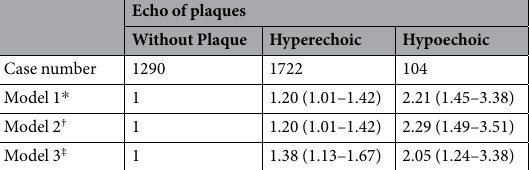
Table 4. Odds ratios of cognitive impairment by echo character of plaques. * Adjusted for age, sex. † Adjusted for as model 1 plus education level, marriage status, alcohol use, tobacco use, physical activity, hypertension, diabetes, hypercholesterolemia, atrial fibrillation and coronary artery disease. ‡ Adjusted for as model 2 plus NIHSS and TOAST. NIHSS: National Institutes of Health Stroke Scale; TOAST: Trial of Org 10172 in Acute Stroke